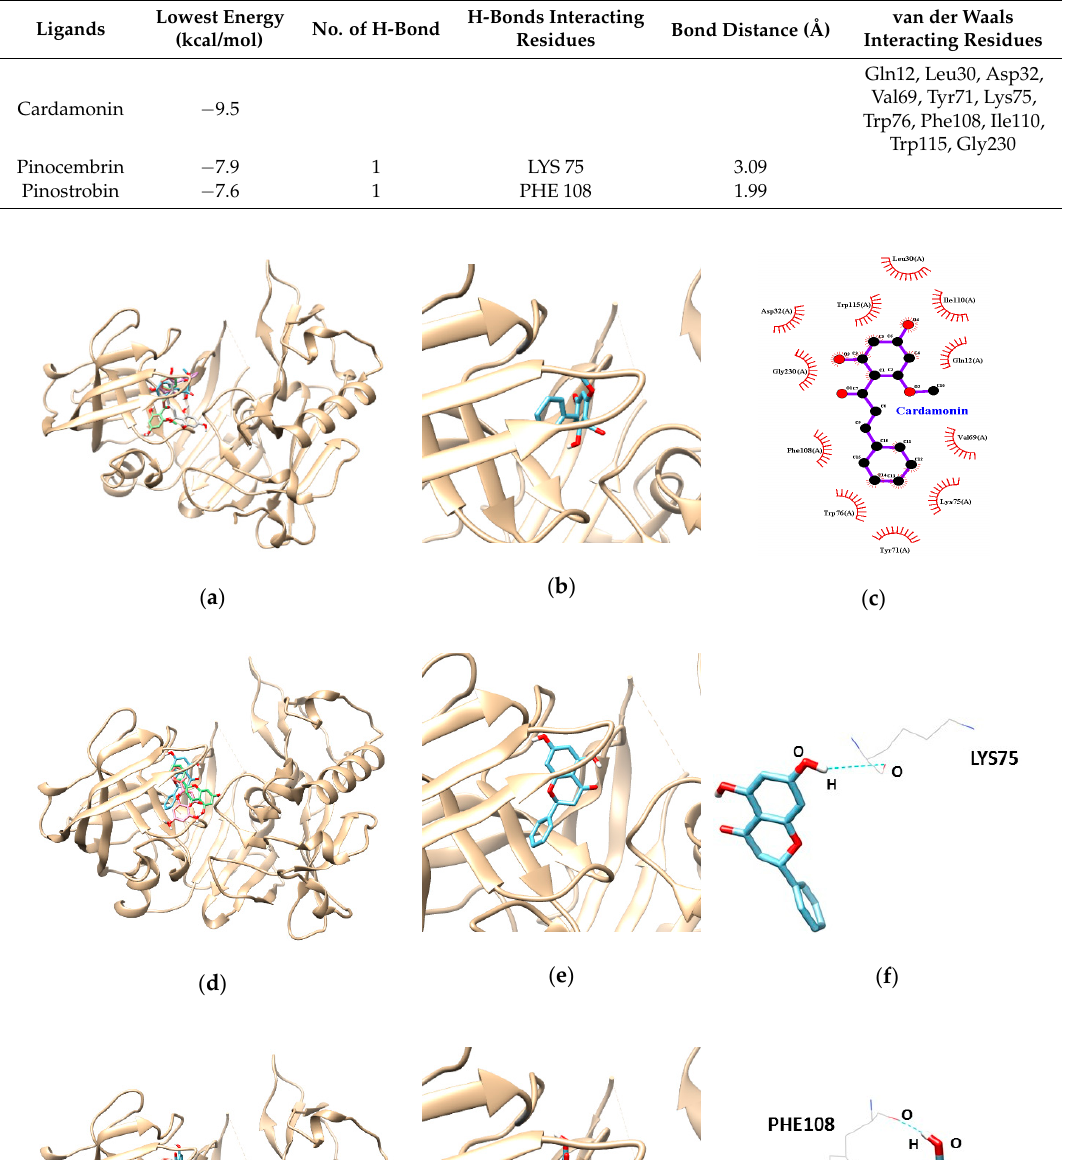
Table 3. Lowest energies and the number of hydrogen bond and hydrophobic interactions of cardamonin, pinocembrin, and pinostrobin with BACE1.